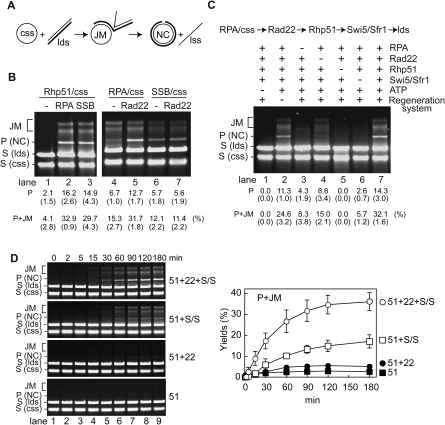
In Vitro Reconstitution of DNA Strand Exchange(A) Diagram of the DNA strand exchange assay. lss, linear single-stranded DNA.(B) Rad22 can overcome the inhibitory effect of RPA on the Rhp51-Swi5-Sfr1–mediated DNA strand exchange reaction. In lanes 1 to 3, Rhp51 was first incubated with css, and then with Swi5-Sfr1, RPA, and lds. In the lane 1 reaction, SSB was omitted. In lanes 2 and 3, RPA and SSB were added, respectively. In lanes 4 and 5, RPA was first incubated with css and then with Rhp51 and Swi5-Sfr1. Rad22 (lane 5) or mock buffer (lane 4) were added 5 min after incubation with RPA. Lanes 6 and 7 are the same as lanes 4 and 5, respectively, except that SSB was used instead of RPA.(C) Requirements for strand exchange. All protein cofactors are required for the reaction. The protein addition order is indicated above the agarose gel image. When a component was not included, it was replaced by stock buffer. The values indicated below each lane in (B) and (C) are average percentages of NC products (P) and conversions (P + JM) obtained in three independent experiments. Standard deviation (s.d.) is indicated in parentheses.(D) Time course of the strand exchange reaction with various protein components as indicated to the right of each gel image. The reaction procedures including the addition order were the same as in (C) except that the reaction volume was 100 μl. Aliquots (10 μl) were taken at various time points, and the reactions were terminated by adding a stop solution, with a final incubation for 30 min at 37 °C. The graph shows quantifications of P + JM. The values and error bars are the average percentage and s.d. of results from three independent experiments. 22, Rad22; 51, Rhp51; S/S, Swi5-Sfr1.